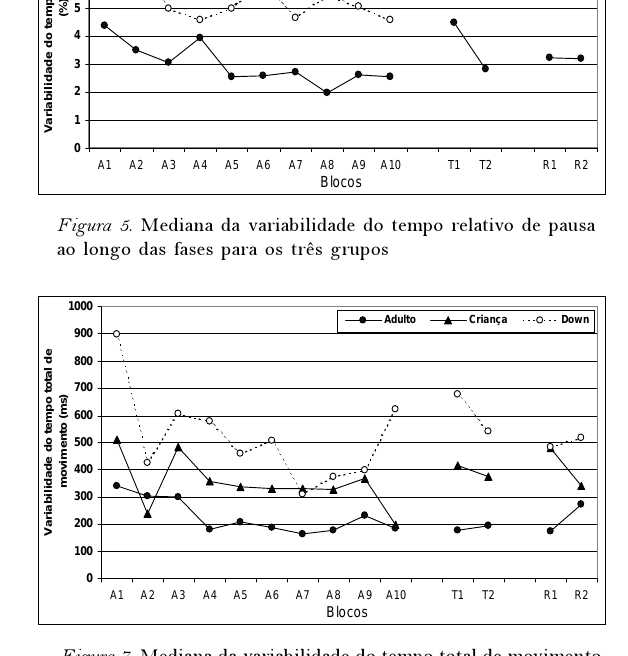
Figura 8 . Mediana da variabilidade do tempo total de pausa ao longo das fases para os três grupos.